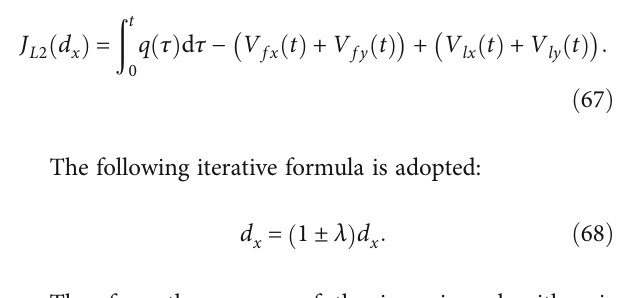
Figure 11: (a) Change of L 126min. (c) Change of L x , L y , and V f with injection rate at 126